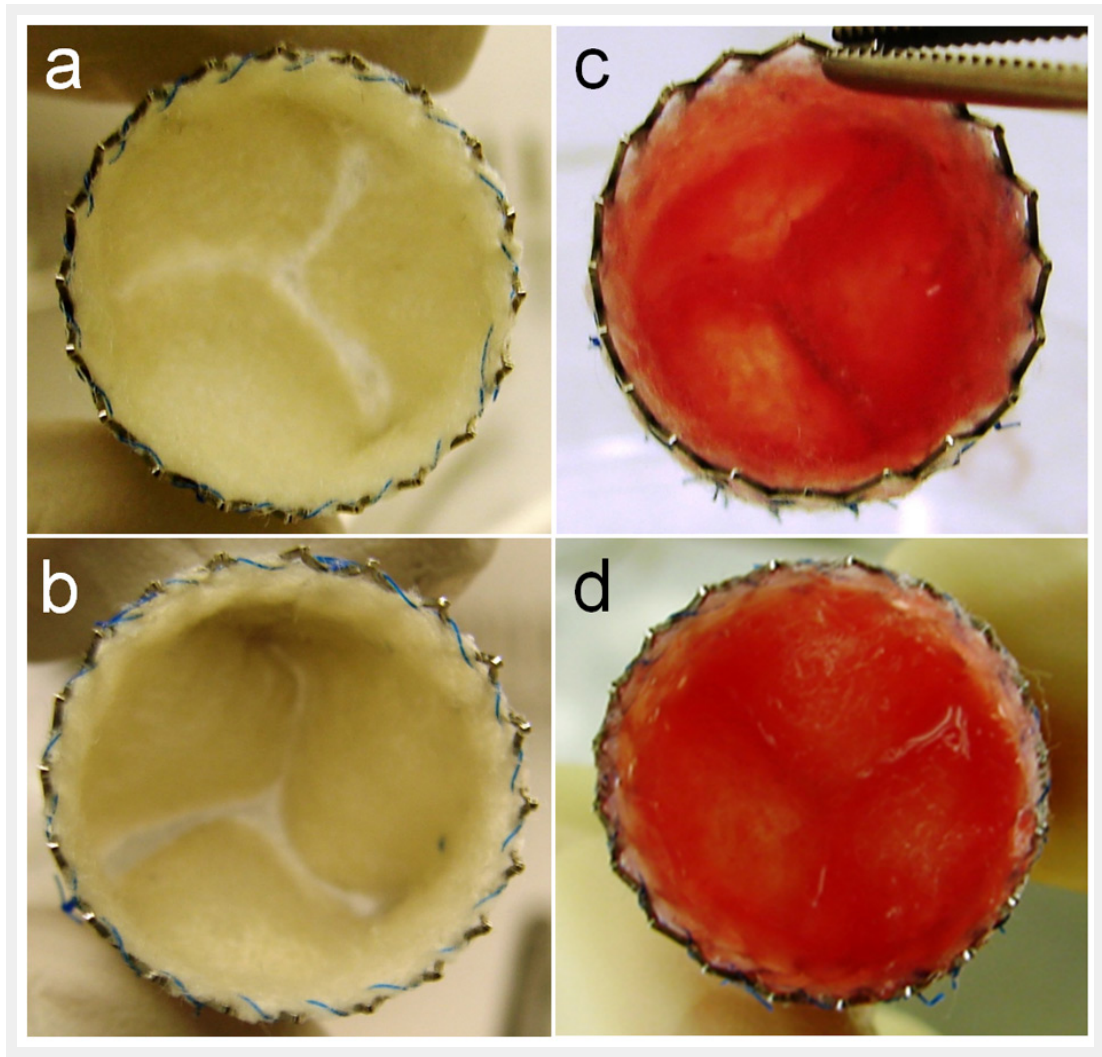
Figure 2 Bone marrow mononuclear cell-based tissue engineered heart valve prior to implantation into an animal model. (Reprinted from [23]: Weber B, Scherman J, Emmert MY, Gruenenfelder J, Verbeek R, Bracher M, et al. Injectable living marrow stromal cell-based autologous tissue engineered heart valves: first experiences with a one-step intervention in primates. Eur Heart J. 2011;32(22):2830–40. © Oxford University Press, Oxford, UK, with kind